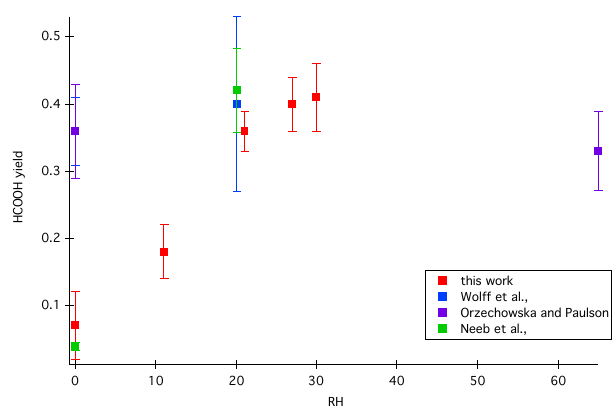
Fig. 6. A comparison of the experimentally determined HC(O)OH